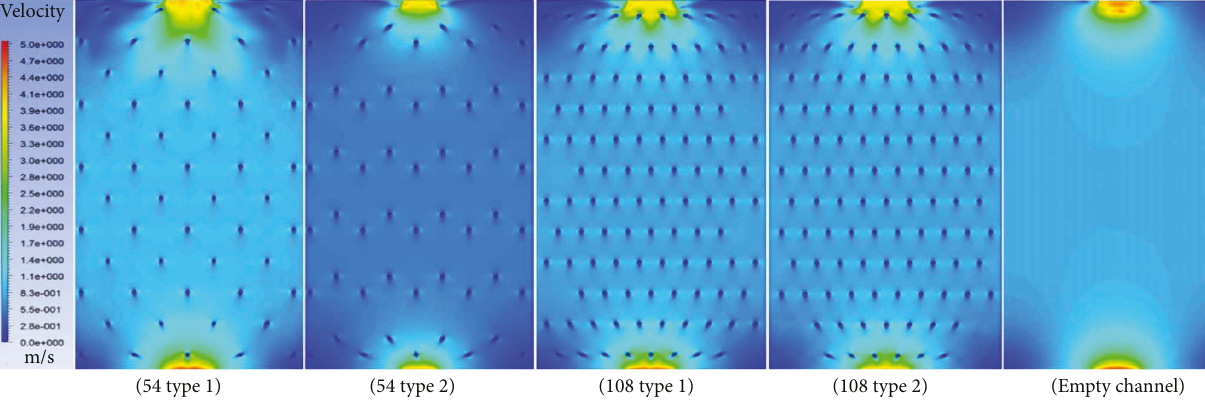
Figure 15: Velocity contours at